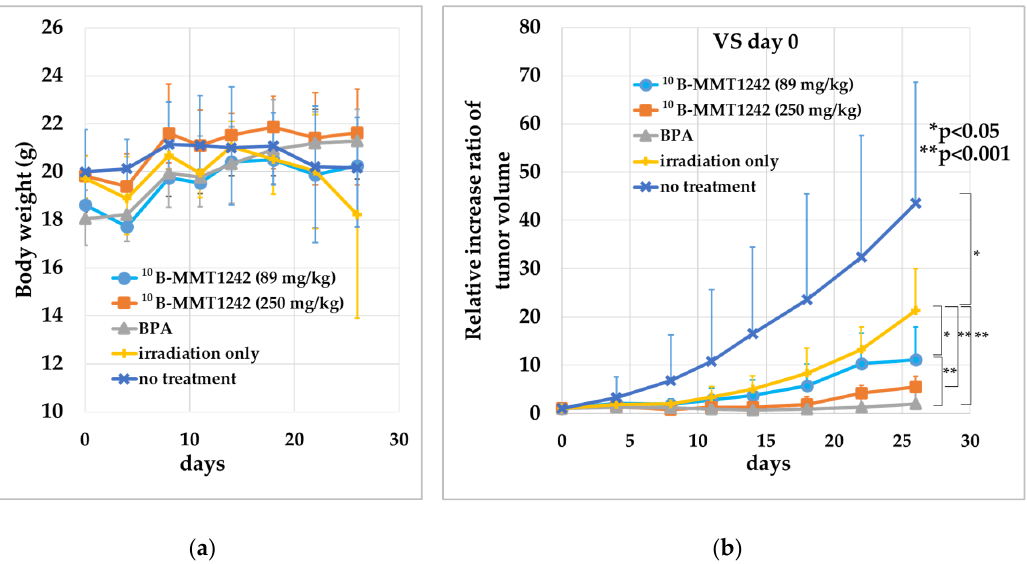
Figure 9. BNCT of tumor-bearing mice with 10 B-enriched compounds. ( a ) Mice body weight after thermal neutron irradiation. ( b ) Tumor growth ratio after 1-h epithermal neutron irradiation (1.8–4.0 × 10 12 neutrons / cm 2 ) after the injection of 10 B-MMT1242 at 24 h and 10 B-BPA at 2 h before irradiation with irradiation-only and untreated groups as controls. Comparisons by t-test for no-treatment and irradiation-only groups, and comparisons by Tukey-Kramer multiple comparison tests for irradiation-only, BPA, 10 B-MMT1242 (89 mg / kg), and 10 B-MMT1242 (250 mg / kg) groups were performed using mice 26 days after